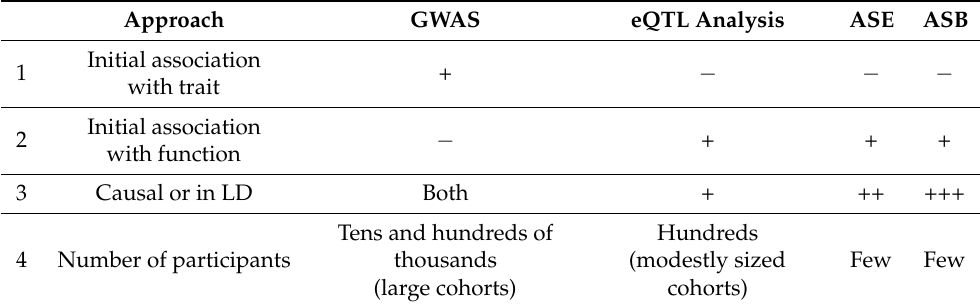
Table 3. Main features of the most widespread approaches to the search for functional